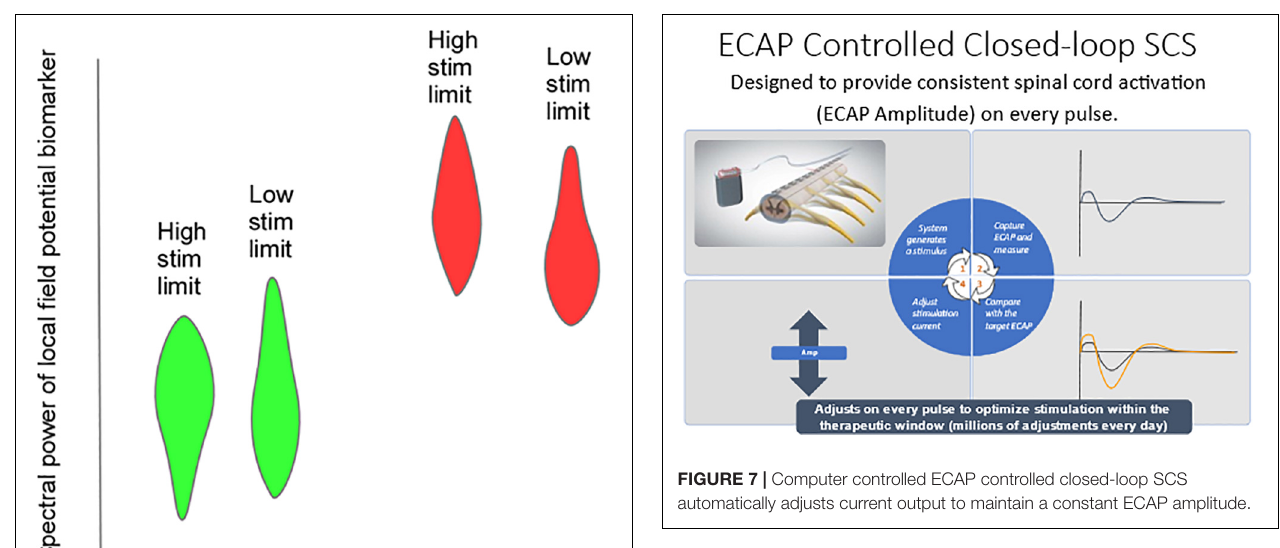
group (84.0 vs. 65.9% subjects, respectively; p = 0.040) ( Figure 3